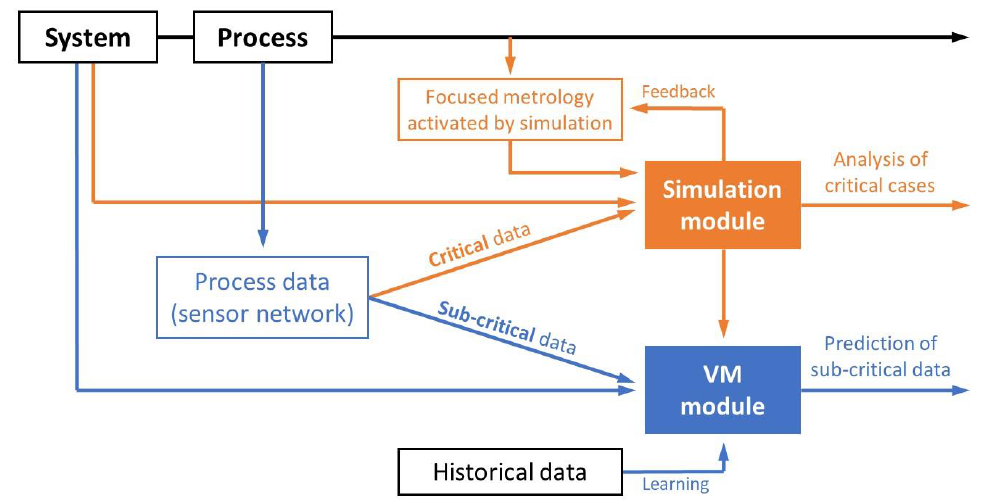
Figure 1. Schematic of a digital twin module integrating both physical–chemical simulations and virtual metrology (VM) tools for a given process. The “sub-critical data” refer to the standard operation of the process machine in the manufacturing chain, the “critical data” refer to anomalous deviations of the output from the process expectations or the output in a development stage (due to, e.g., a new required specification for the process). The focused metrology can be also destructive, while process data are obtained with noninvasive methods.